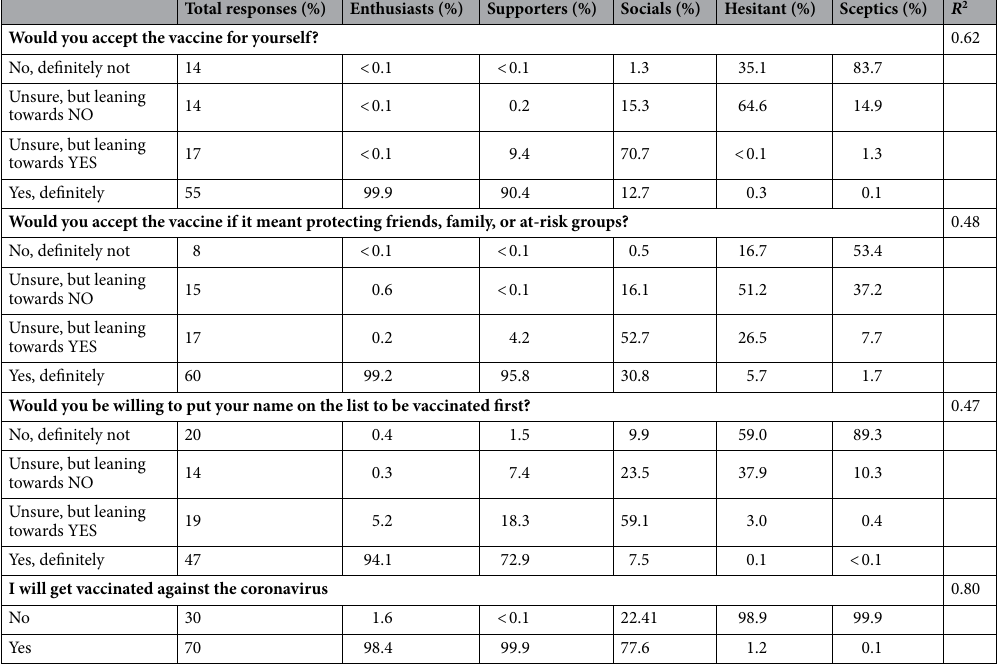
Table 3. Question responses on COVID-19 vaccine intentions across the segments. N = 1054. Table, sourced from Thaker et al., 2022 76 presents percentages of key input variables across the segments. All proportional differences—as judged by ANOVA or chi-square tests—are significant at p < 0.001. R 2 represents how much of the variance of each indicator is explained by this 5-cluster model.